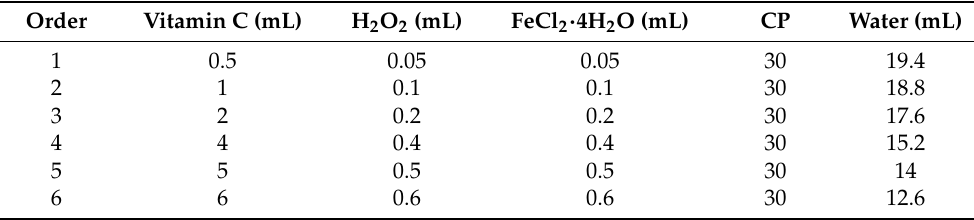
Table 1. The condition of degradation